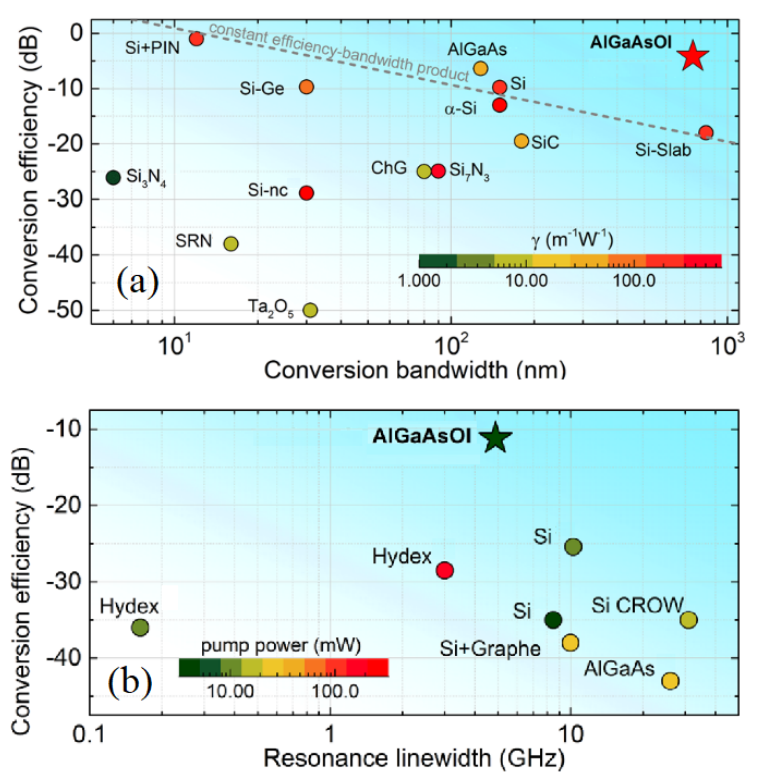
Figure 12. FWM conversion efficiency reported in ( a ) waveguides and ( b ) microring resonators fabricated in different material platforms. This figure was adapted with permission from Ref. [140] whose results are marked with the stars on the graphs. The works reporting other results marked with circles can be found in Ref.